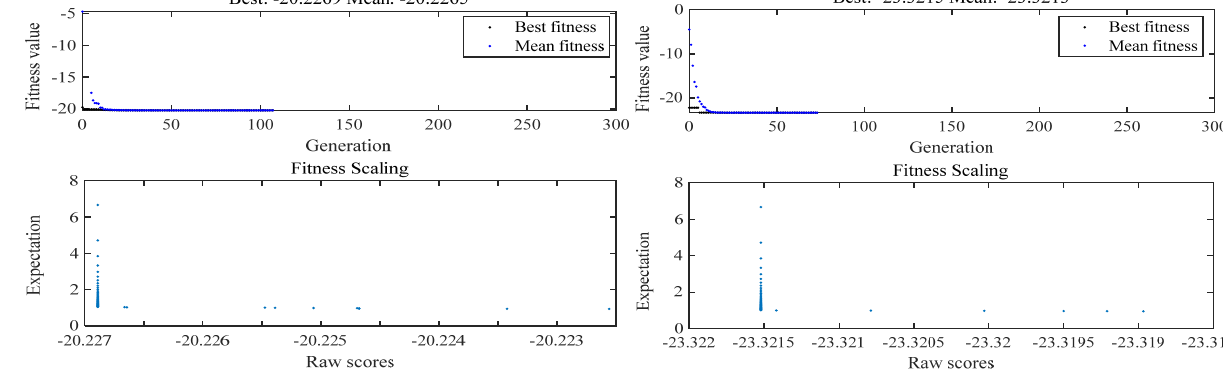
Figure 10. Genetic algorithm operation results.